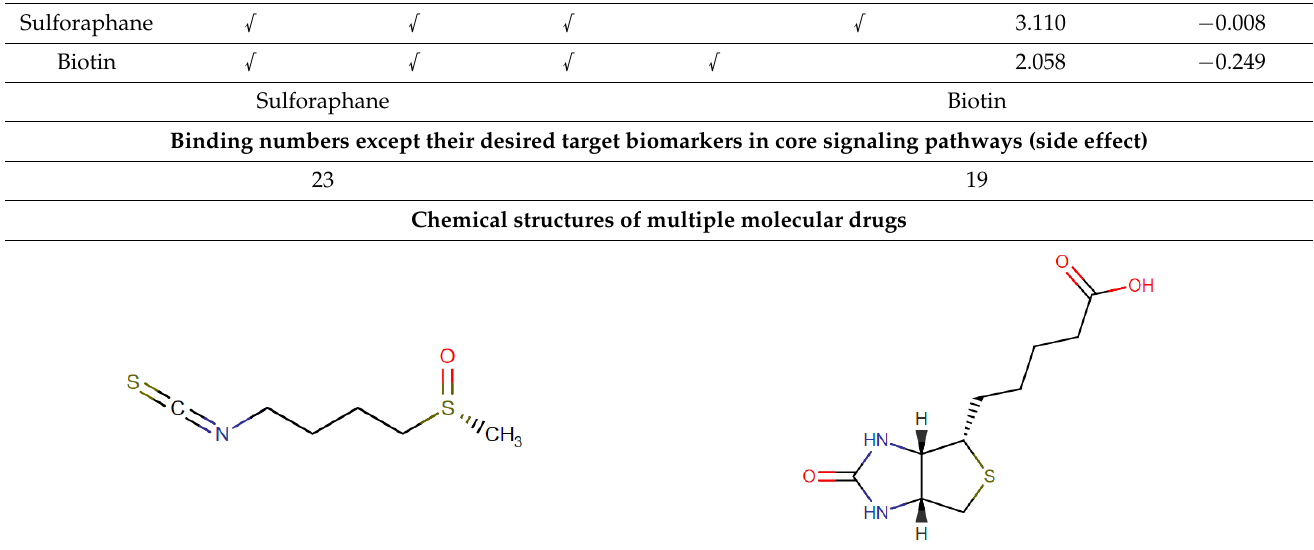
Table 7. The drug design specifications of a potential multiple-molecule targeting drug for T2D. Regulation Ability to Specific Biomarkers Drug Names